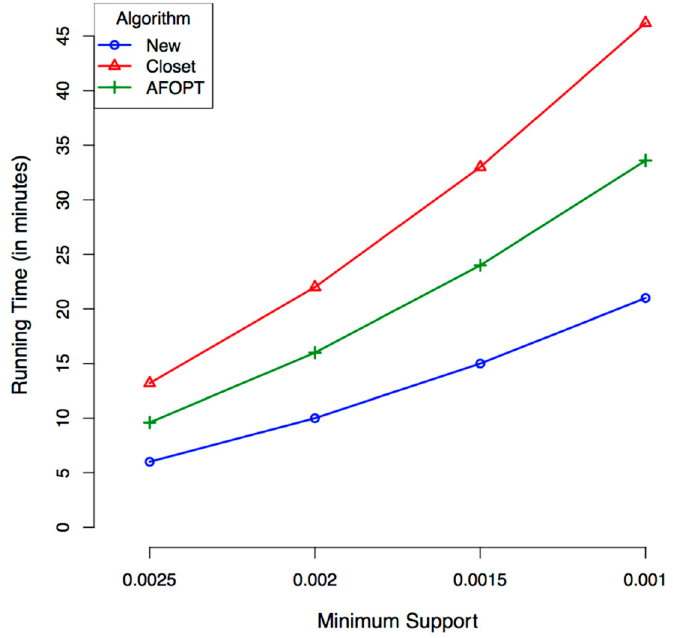
Algorithms 2018 , 11 , x FOR PEER REVIEW Figure 5. Running time of the algorithms on the synthetic data. Figure 5. Running time of the algorithms on the synthetic data.